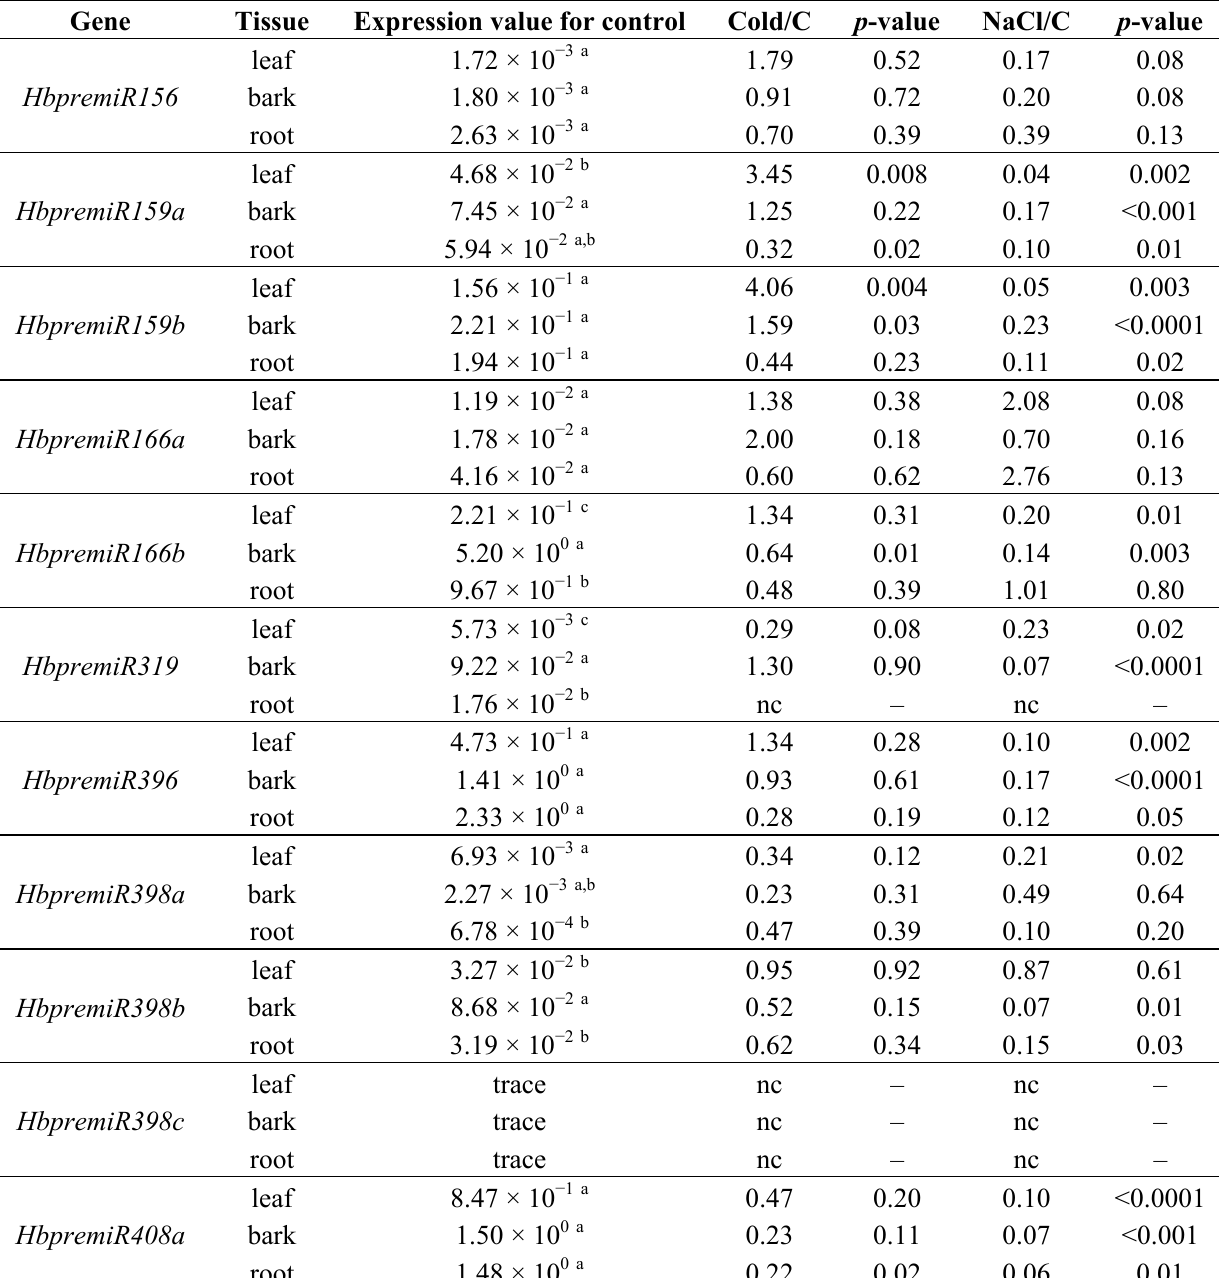
Table 1. Relative premiR abundance of 13 conserved MIR genes and 7 MIR genes newly identified in Hevea brasiliensis in the leaves, bark and roots of one-year-old in vitro plantlets in response to cold and saline (NaCl) treatments compared with non-treated plants (C: control), nc: not calculated. Data with the same letter are not significantly different at the level of